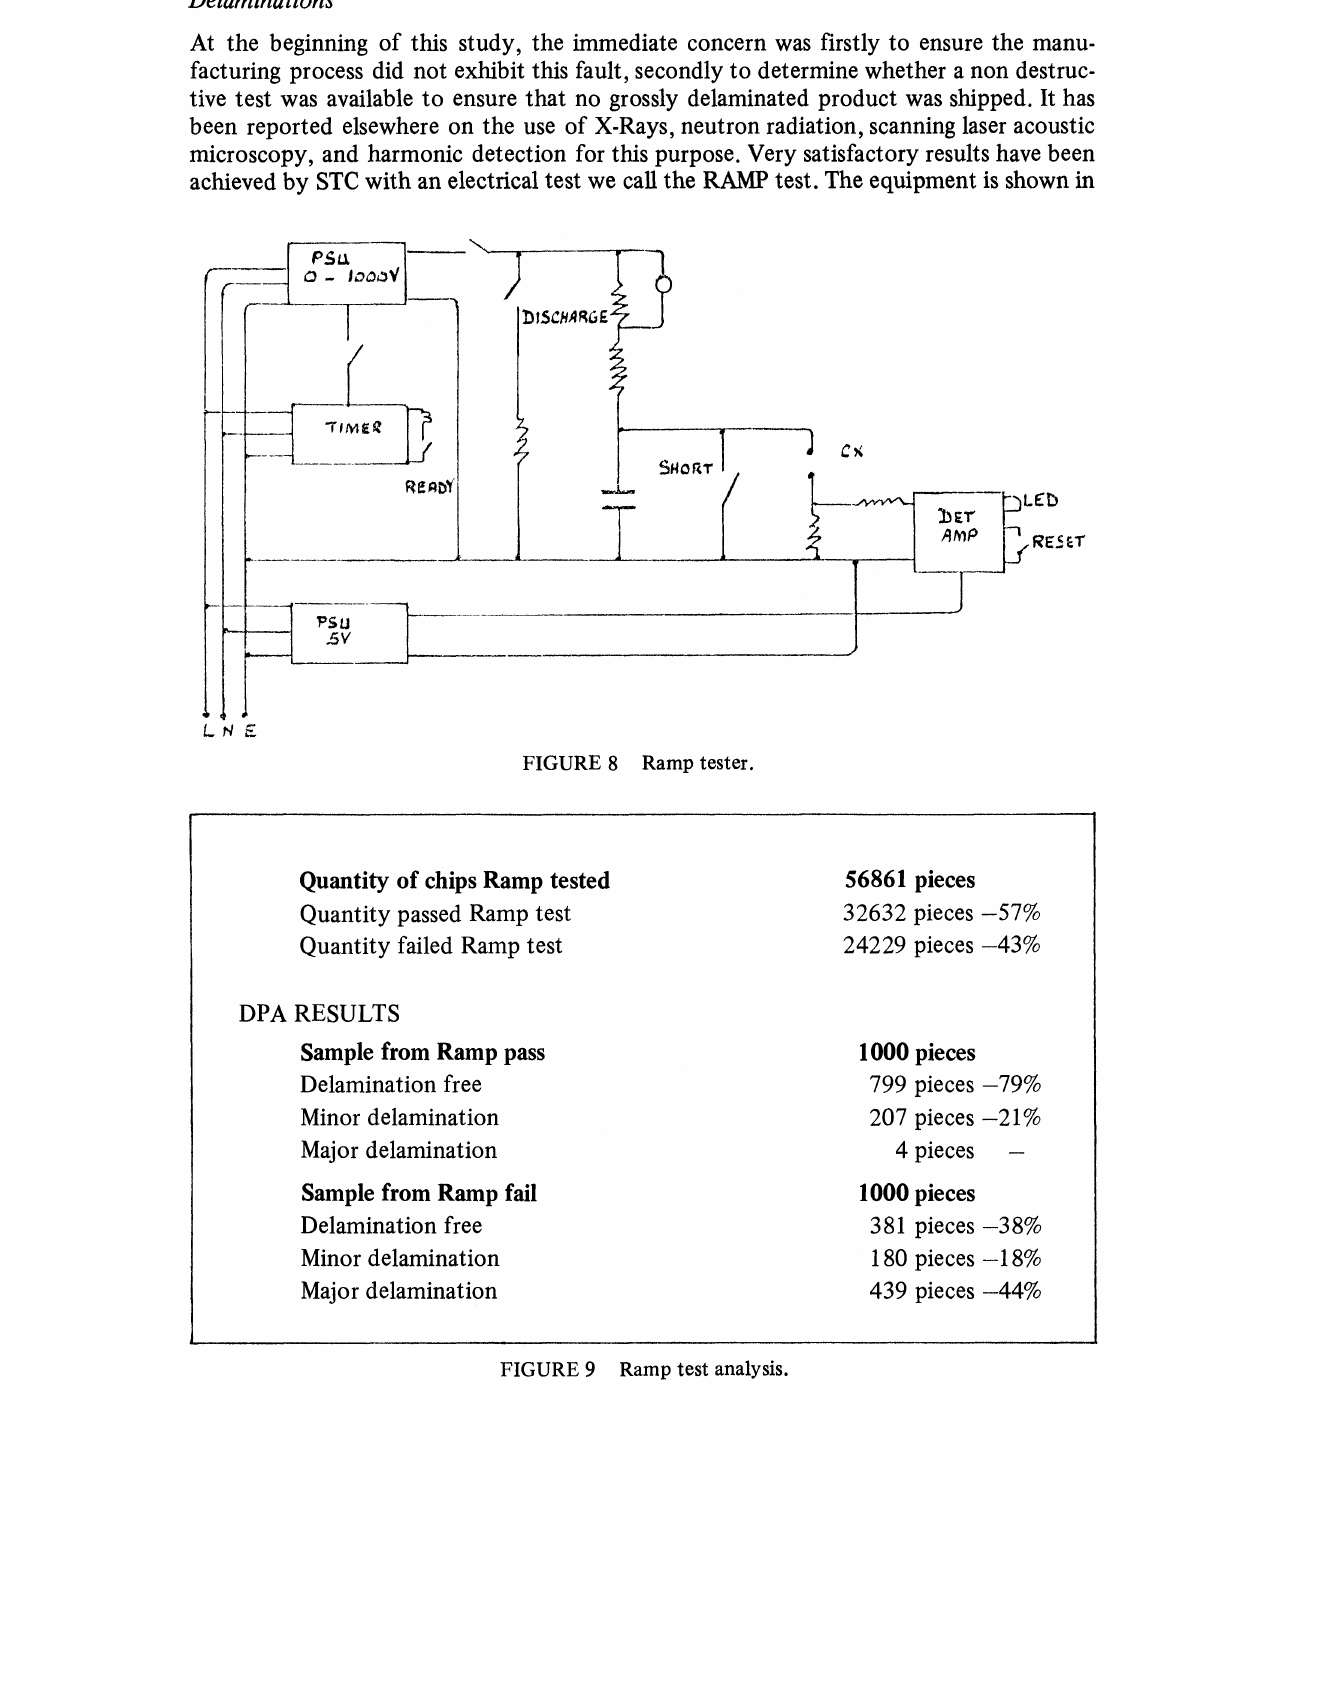
FIGURE 9 Ramp test